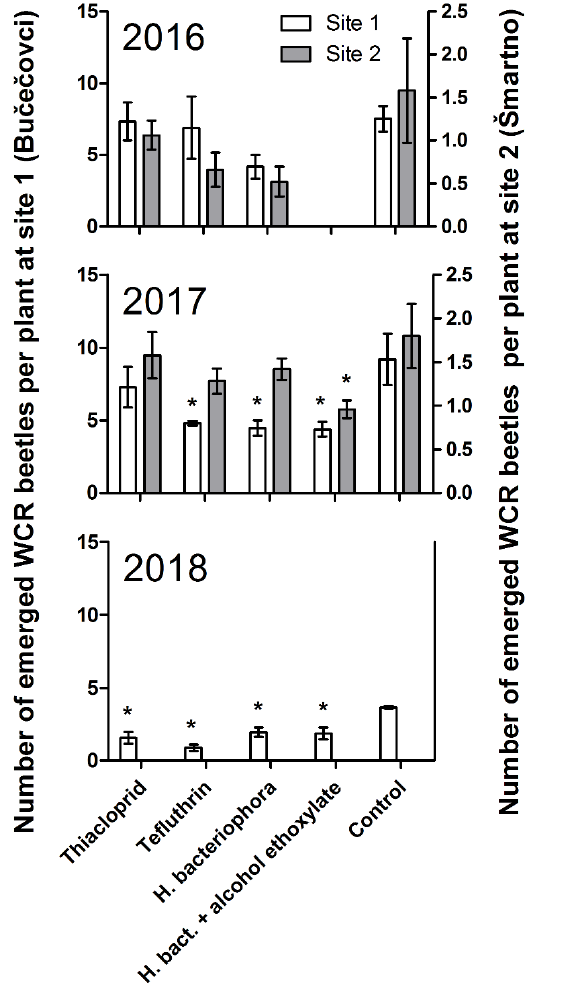
Figure 2. The number of western corn rootworm (WCR) beetles per plant that emerged and were caught on the yellow sticky trap in the 1-m 2 emergence gauze cages, covering 12 plants, on both field sites in the three consecutive years (2016–2018) of field experimentation. Graphs show average and standard errors ( n = 25 for all treatments, except 15 for H. bact. + alcohol ethoxylate). Asterisks indicate significant differences from the respective controls ( p < 0.05). H. bact. — H. bacteriophora. Table 4. Effect of different treatments on fresh plant weight and fresh grain yield per plant. Yield was assessed by weighing ears (fresh, with husks) from five plants. Data presented are averages ± standard error ( n = 20 for all treatments, except n = 15 for H. bacteriophora + alcohol ethoxylate). Treatments not sharing the same letters are significantly different.